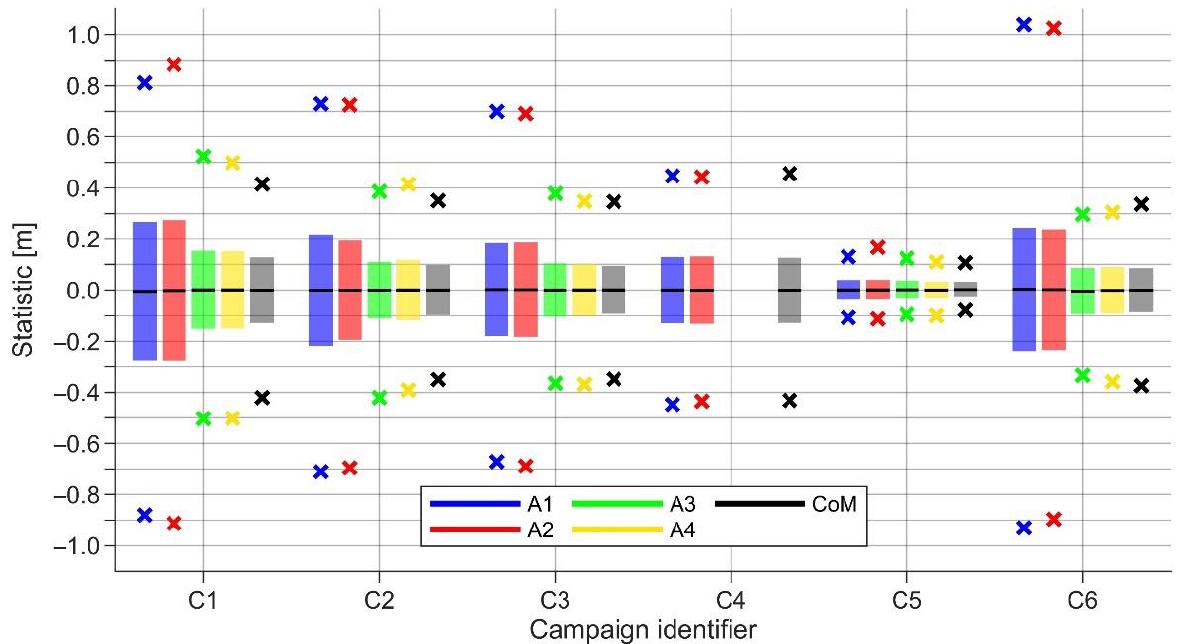
Figure 12. Statistical properties of differences between unfiltered and filtered residuals (filtered results were subtracted from unfiltered) for antennas A1–A4 and the mass center solution (denoted CoM). The black lines are mean values, and colored bars denote standard deviation estimates. Crosses show 99th percentile minimum and maximum differences.